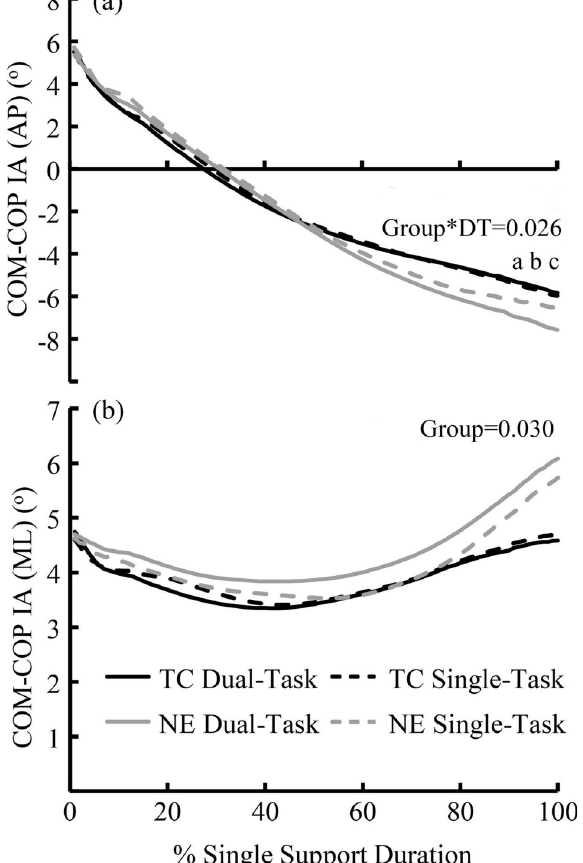
Fig 2. Center of mass–center of pressure inclination angle (COM–COP IA). TC: Tai Chi group, NE: no-exercise group. COM-COP AI: Center of Mass-Center of Pressure Inclination Angle. AP: anteroposterior direction, ML: mediolateral direction. a: Significant difference between the DT and ST conditions among the NE practitioners. b: Significant difference between the TC and NE practitioners under the DT conditions. c: Significant difference between the TC and NE practitioners under the ST